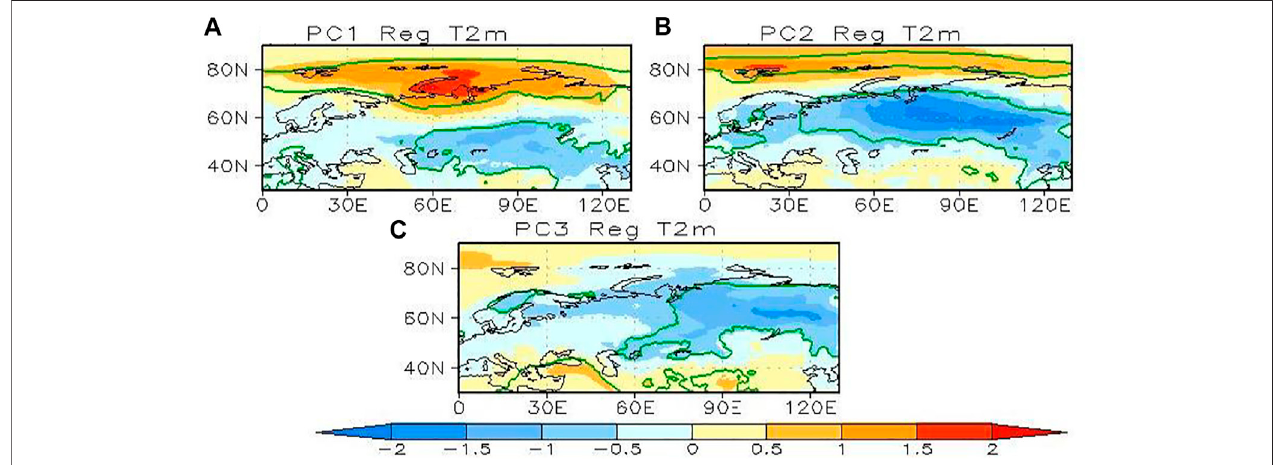
FIGURE 4 | Regressed anomalies of DJF T2m (shading, units: C) onto the (A) PC1, (B) PC2, and (C) PC3 index. The green line indicates the value signi fi cantly exceeding the 95% con fi dence level.